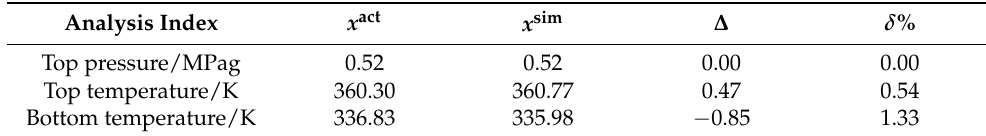
Table 5. Comparison of main process indexes of C01.